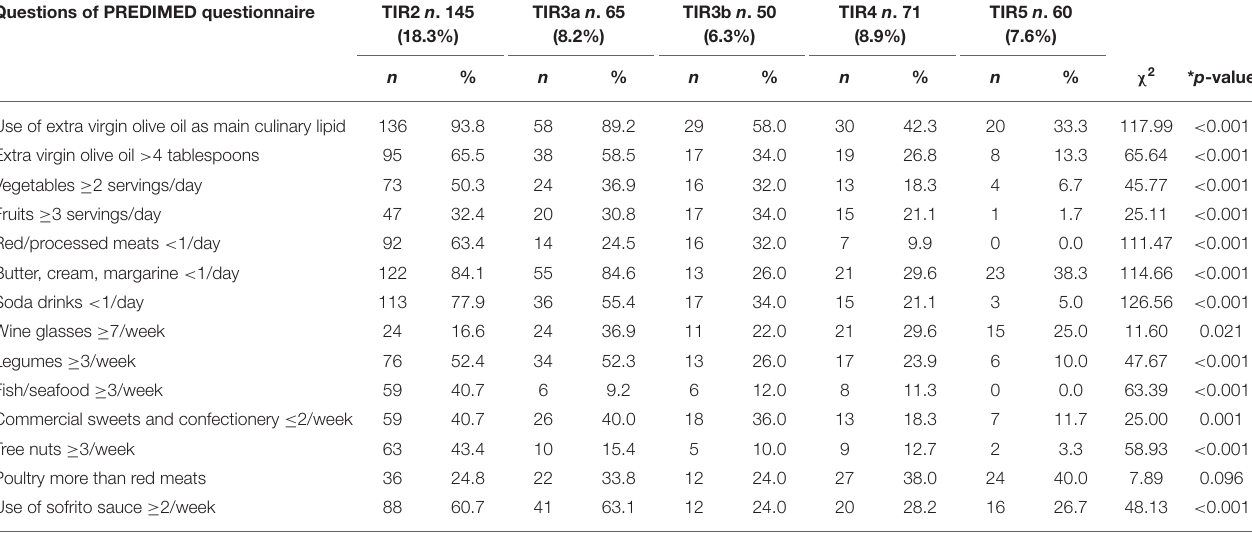
TABLE 5 | Responses of each item included in PREDIMED questionnaire in the study population grouped according to the five diagnostic cytology categories based on 2013 Italian thyroid cytology classification system. Questions of PREDIMED questionnaire